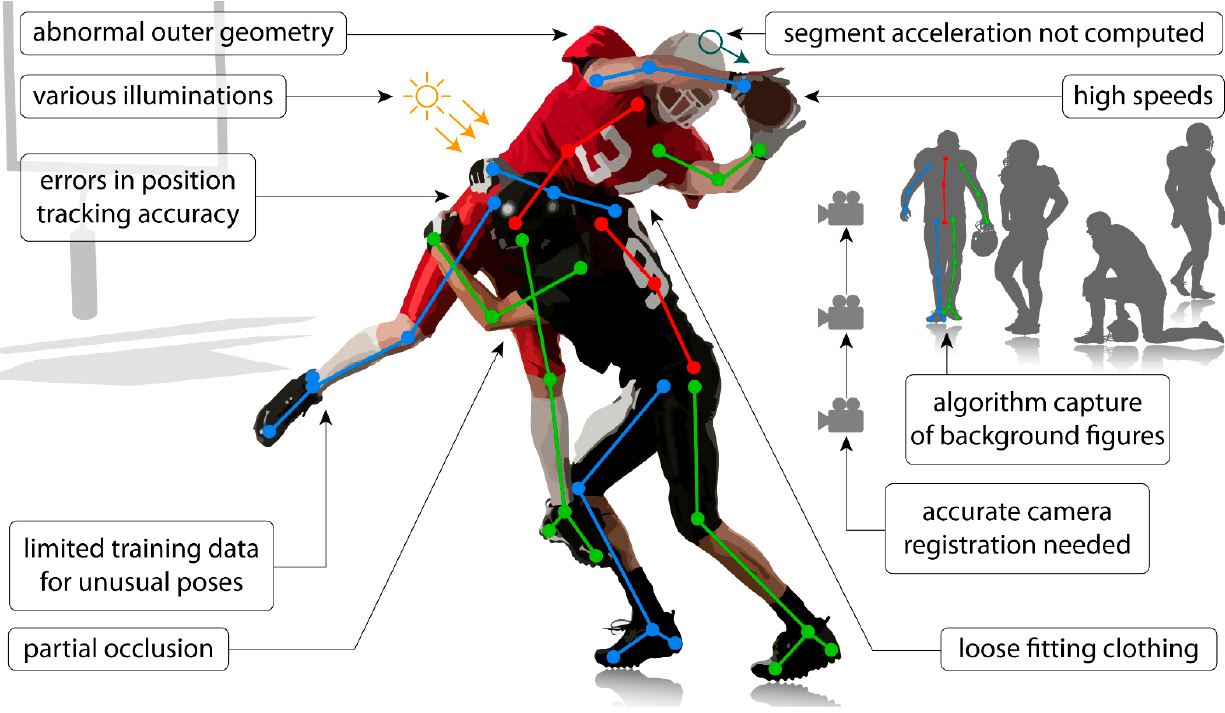
Figure 5. Common application limitations with current pose estimation algorithms and challenges with using these algorithms outside of the laboratory. These applications commonly require three-dimensional kinematics of multiple people moving at relatively high speeds to be tracked in environments with background figures (e.g., irrelevant people and objects shaped similarly to people). This leads to challenges with segment occlusion, unintentional capture of background figures, and registration of multiple cameras. Additionally, using current algorithms for scenarios different than the training dataset (e.g., different movements, different types of clothing or equipment being worn, different lighting) may lead to reduced accuracy in the predicted kinematics or, potentially, failure of the algorithm. Finally, most algorithms do not predict kinematic metrics that are required for some applications (e.g., head acceleration to assess concussion risk), and limitations with using current algorithms on time-series data make it challenging to accurately derive these